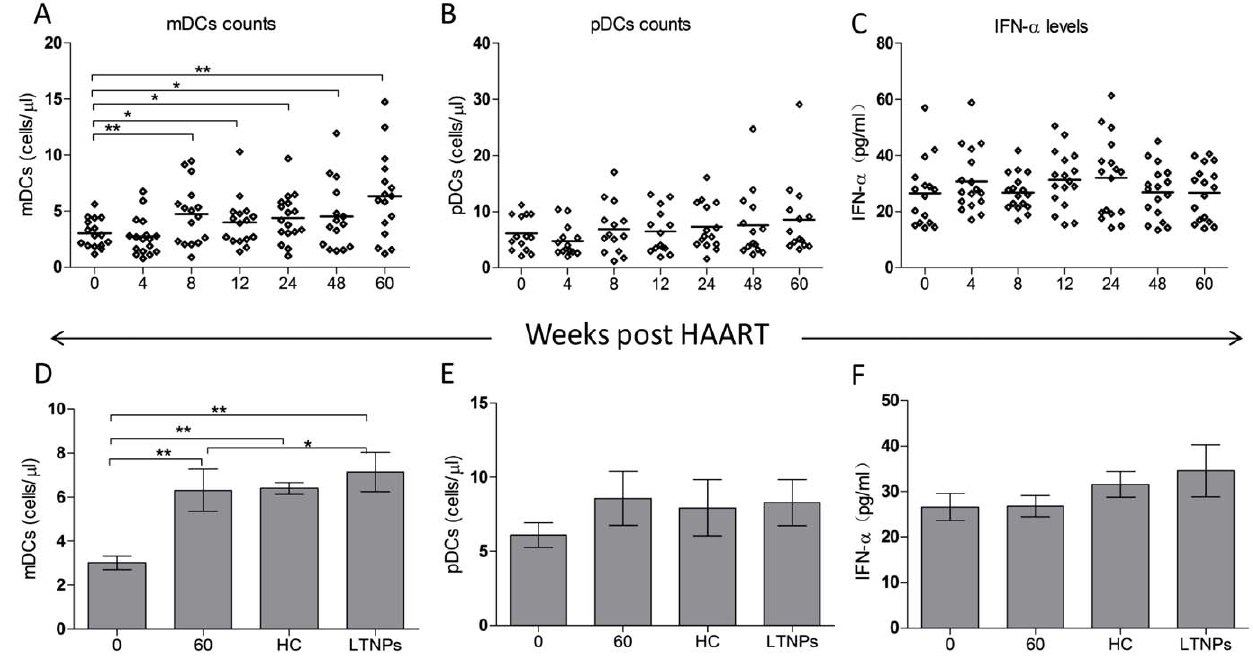
Figure 1. Longitudinal changes in DC subsets and IFN-a plasma levels during ART (weeks). (A–C) Longitudinal changes in counts of mDCs, pDCs and IFN-a plasma levels in HIV-1-infected patients during ART. (D–F) Comparisons of mDCs, pDCs and IFN-a plasma levels among HIV-1- infected patients at week 0, week 60, healthy controls and LTNPs. ** p , 0.01, * p , 0.05. doi:10.1371/journal.pone.0037966.g001 PLoS ONE |